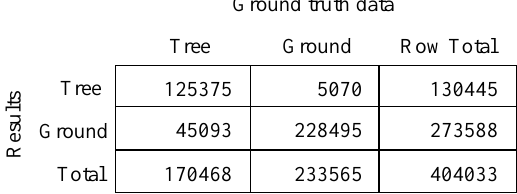
Table 9. Error Matrix of the 1 st test case (FW LiDAR)